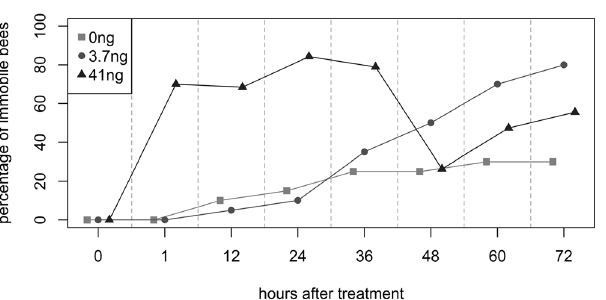
Figure 4. Imidacloprid-exposed bees partly recovered from paralysis after 48 hours. Individual honeybees were fed with a single dose of sugar syrup control or a dosage of 3.7 and 41 ng/bee imidacloprid (20 bees per treatment group, single experiment). After one, 12, 24, 36, 48, 60, and 72 hours bees were examined for activity. Non-moving bees were counted as immobile. After one hour, 70% of the bees of the 41 ng treatment were immobile, but recovered to the same level of immobility as the control after 48